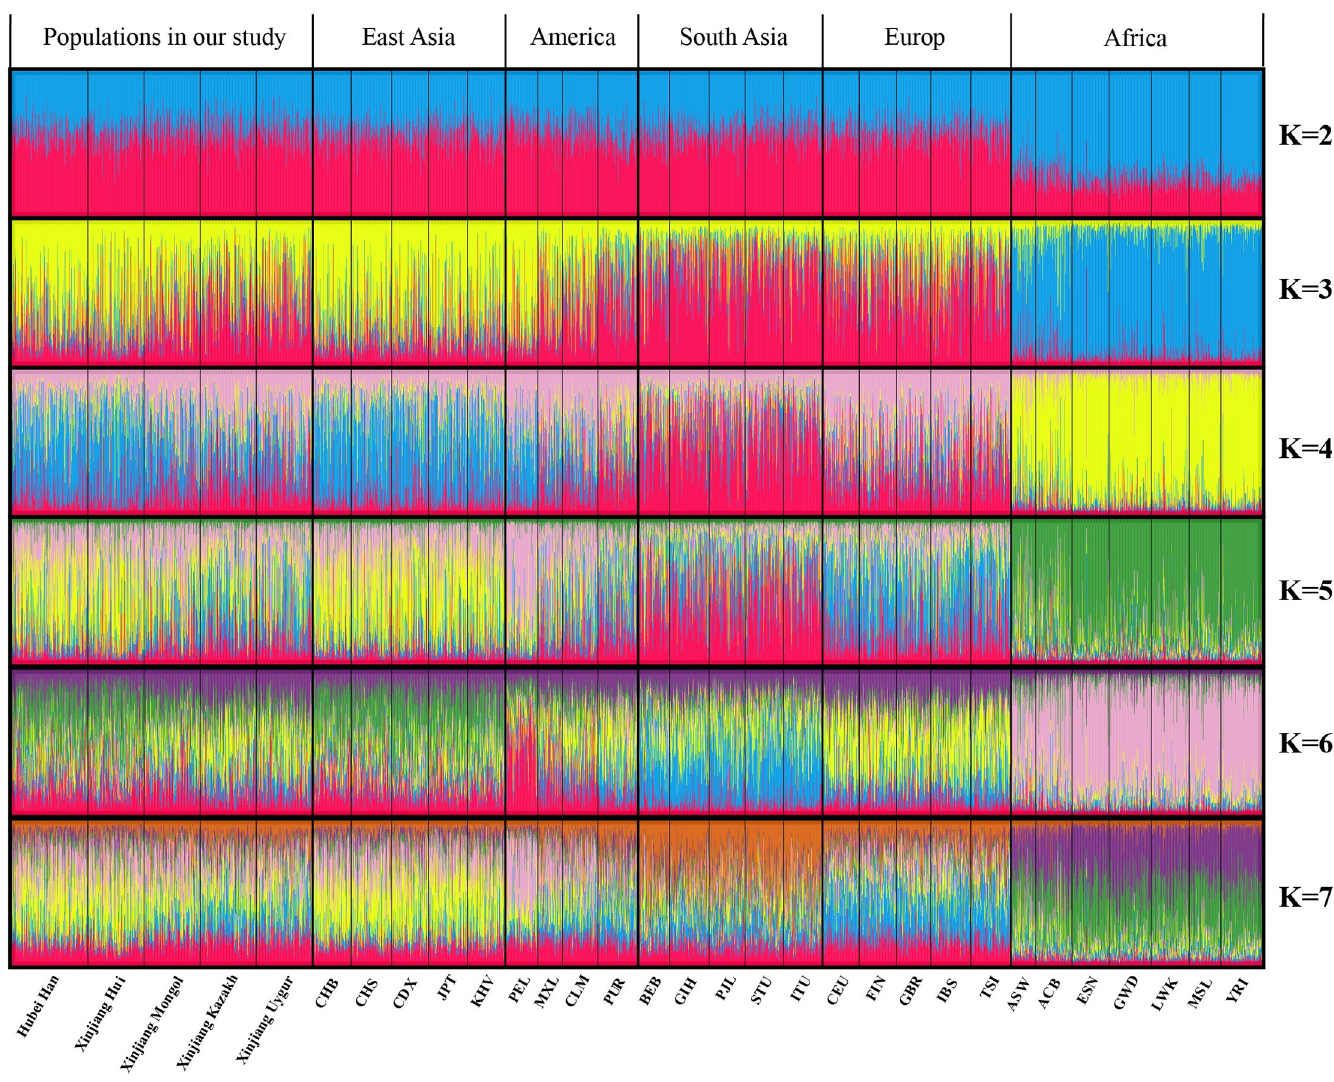
structureHarvester/), the Delta K maximises at K = 3 and thus the optimal K value was esti- mated to be K = 3 [31]. When K = 2, only AFR could be distinguished from the rest popula- tions. At K = 3, the 31 populations could be divided into 4 structure types: EAS (mainly in yellow); AFR (mainly in blue); EUR and SAS (mainly in red); Xinjiang Mongol, Kazakh, Uygur, and AMR (mixture of yellow and red). At K = 4–7, EUR could be distinguished from SAS by different ancestral components, and the genetic structure of Xinjiang Mongol, Kazakh and Uygur were similar with EUR. The ancestry proportions of Hubei Han and Xinjiang Hui were similar with EAS at K = 2–7. These results were consistent with the locus by locus AMOVA analysis, PCA, and phylogenetic tree. Since there is no data of rs35149698 in the 1000 Genomes Project, we only compared the forensic parameters of 31 InDels between Xinjiang west-east mixed populations and EAS or EUR. As is shown in S6 Table, the MH , MH , MPIC, CPD and CPE of these 31 InDels in obs exp